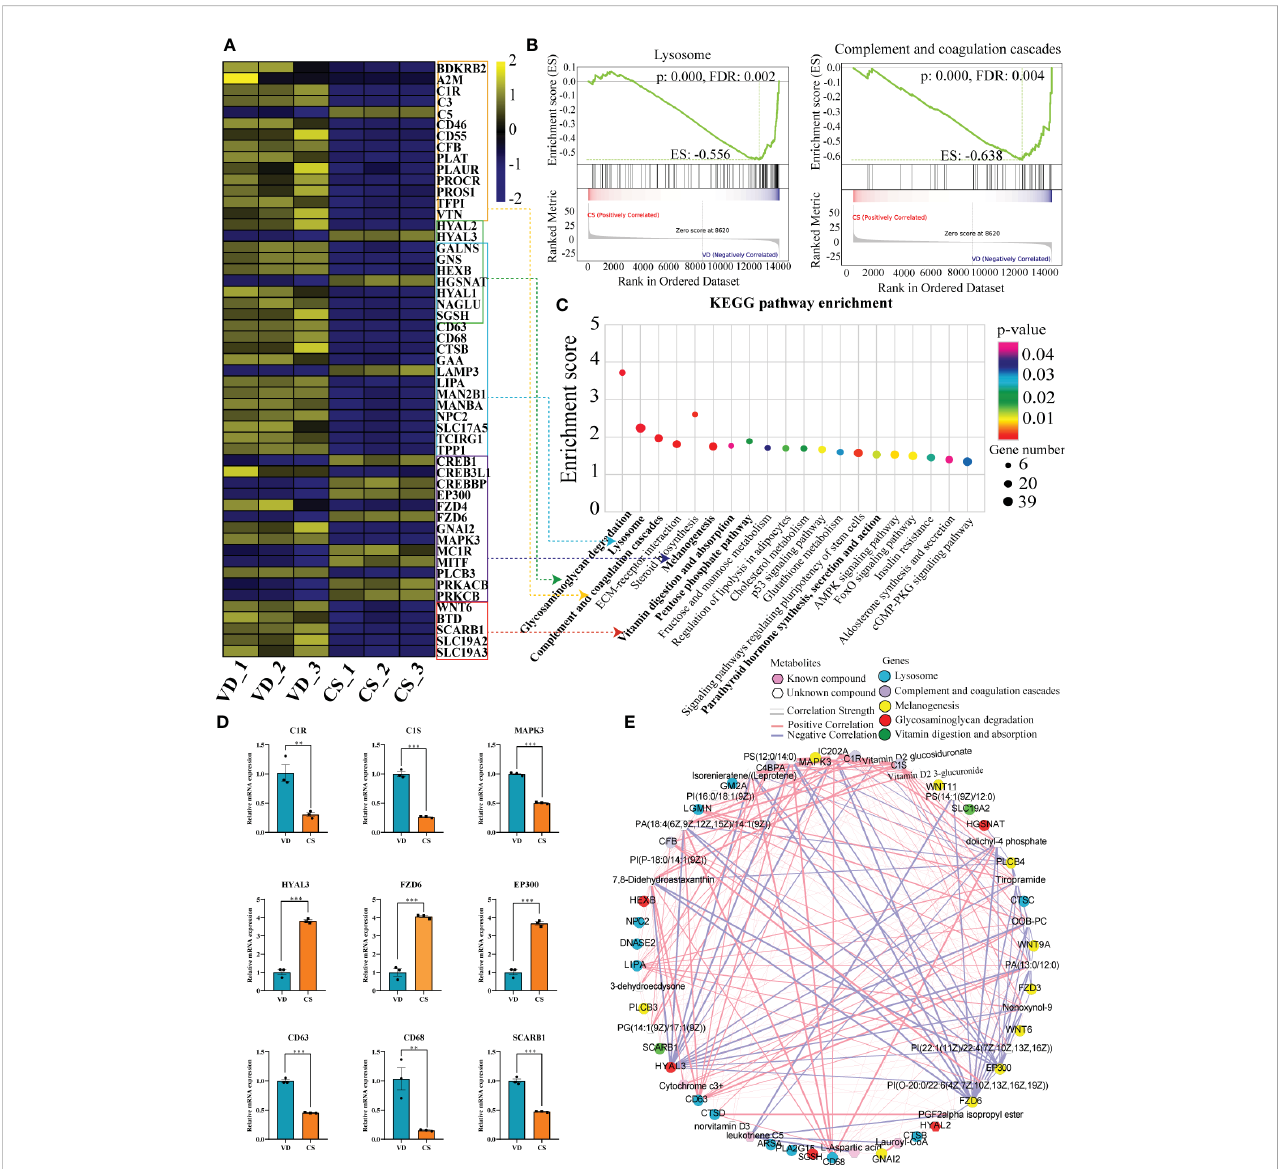
FIGURE 6 Correlation analyses of differential transcripts and metabolites. (A) , Heat map comparing the expression of DEGs between CS AF- (n = 3) and VD AF- treated (n = 3) human intestinal epithelial NCM460 cells. In the heat map, yellow represents high expression, and blue represents low expression. (B) , Gene Set Enrichment Analysis (GSEA) for the potential altered pathways between CS AF- and VD AF-treated NCM460 cells. (C) , KEGG pathway enrichment analysis indicated that the lysosome, glycosaminoglycan degradation, and complement and coagulation cascades were signi fi cantly enriched by DEGs. (D) , Validation of DEGs involved in above pathways between CS AF- (n = 3) and VD AF-treated (n = 3) group by using RT-qPCR. The change in fold-expression was calculated by the 2- ΔΔ CT method using GAPDH as a reference gene. Error bars represent SEM. **p < 0.01; ***p < 0.001. (E) , Correlation-based joint analysis between the representative differentially expressed metabolites (DEMs) and